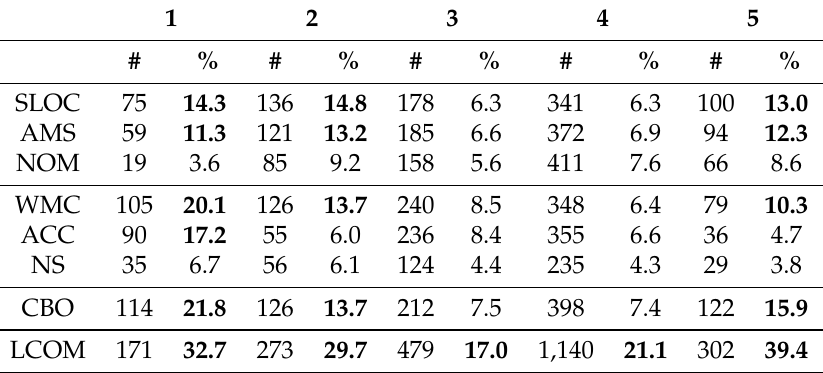
Table 5. Number of potentially deficient classes within KeePass (1); OpenCBS (2) iTextSharp (3); OnlyOffice (4) and Git Extensions (5) identified by using each software metric